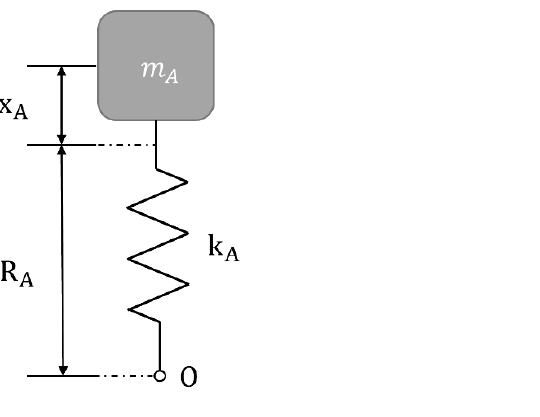
Figure 8. The force on the CVT for numerical analysis.